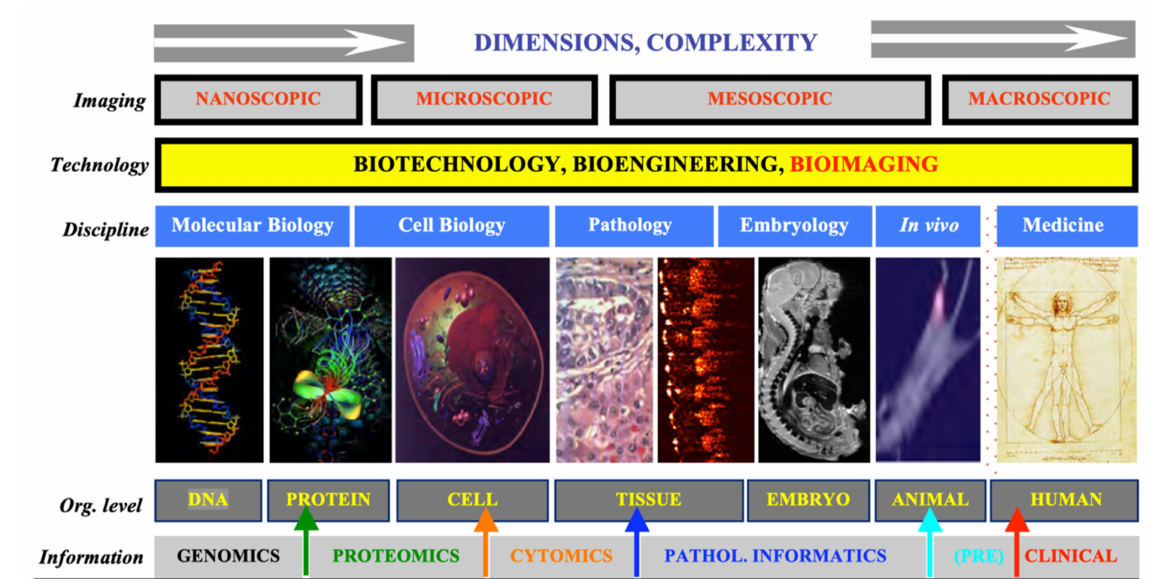
Figure 1. Translational research from molecules to humans, highlighting the central role of optical bioimaging. Pharma/biotech are focusing on DNA/protein-level solutions (green arrow), our best imaging is at the cellular level (orange arrow), but most advanced optical imaging stops at the preclinical level (turquoise arrow). Diagnosis and clinical decision-making are based on pathology (blue arrow), while clearly the need and resources peak at the clinical level (red arrow). We aim to superimpose these arrows towards the clinical end, overcoming the translational brick wall (dotted lines to the right). We focused on advanced, multimode methods that help overlapping the left arrows onto the right two (rather than the reverse, as in biopsies), by expanding quantitative molecular imaging from (sub)cellular microscopy to preclinical studies and the clinic. (modified from